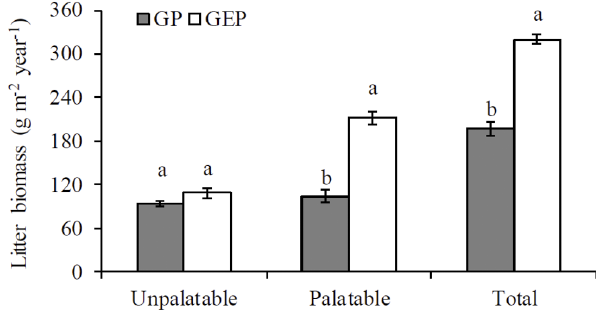
Figure 1. Mean ( ± SE) annual biomass of litter collected from graz- ing paddocks (GP) and grazing exclusion paddocks (GEP). For each category, columns with different letters are significantly different (ANOVA: P < 0 . 05).